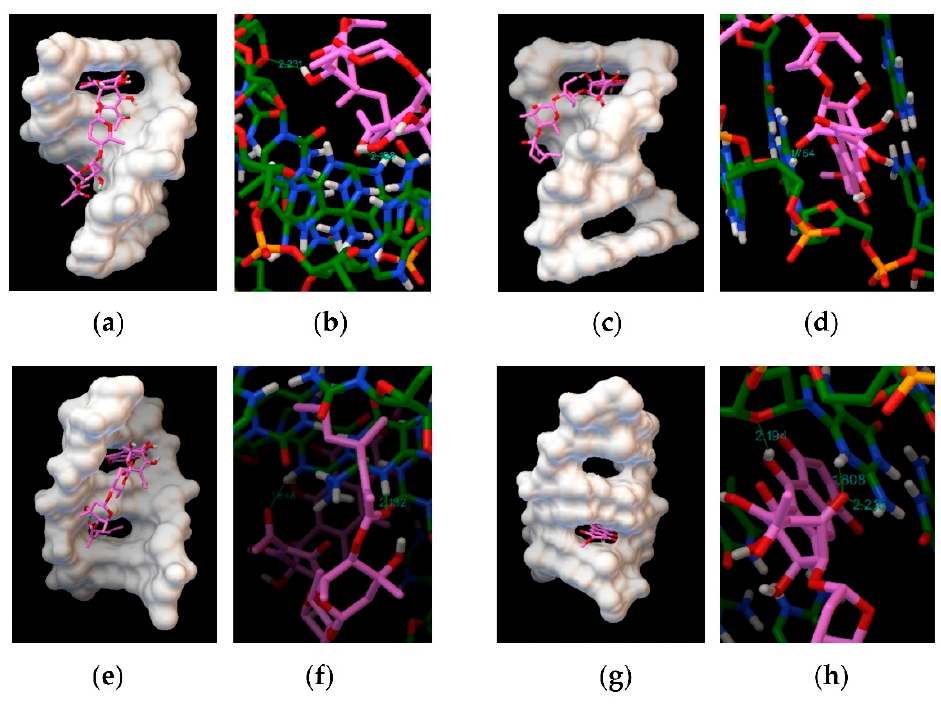
Figure 9. Computational docking model DNA (DNA model with gaps): ( a ) binding mode of dutomycin to DNA (PDB ID 1Z3F); ( b ) hydrogen bond position and distance between dutomycin and DNA (PDB ID 1Z3F); ( c ) binding mode of SW91 to DNA (PDB ID 1Z3F); ( d ) hydrogen bond position and distance between SW91 and DNA (PDB ID 1Z3F); ( e ) binding mode of dutomycin to DNA (PDB ID 4JD8); ( f ) hydrogen bond position and distance between dutomycin and DNA (PDB ID 4JD8); ( g ) binding mode of SW91 to DNA (PDB ID 4JD8); ( h ) hydrogen bond position and distance between SW91 and DNA (PDB ID